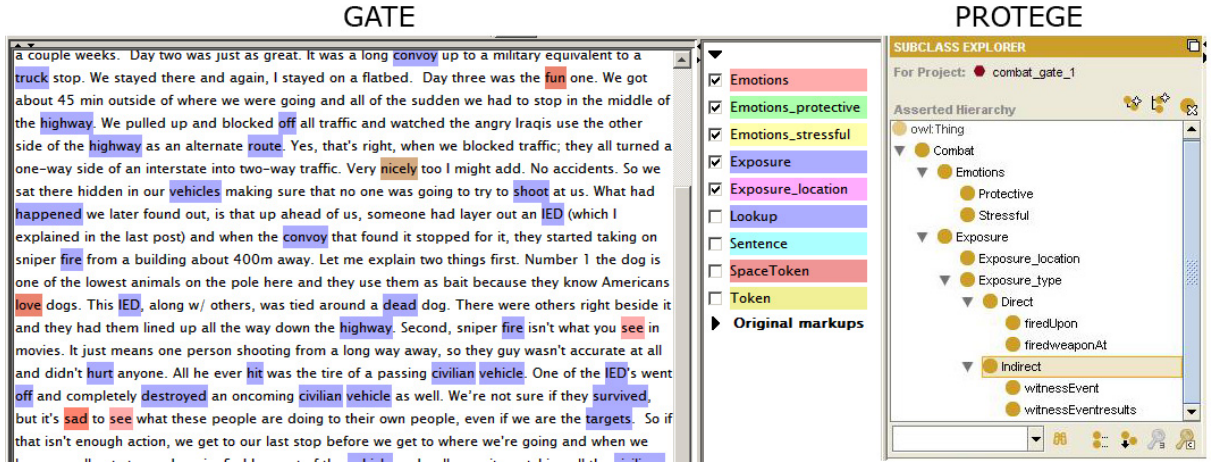
Figure 1. Use of ontology in GATE